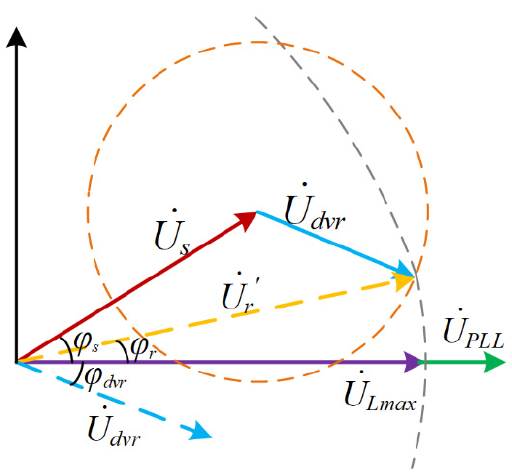
Figure 8. Limit voltage compensation strategy 2.